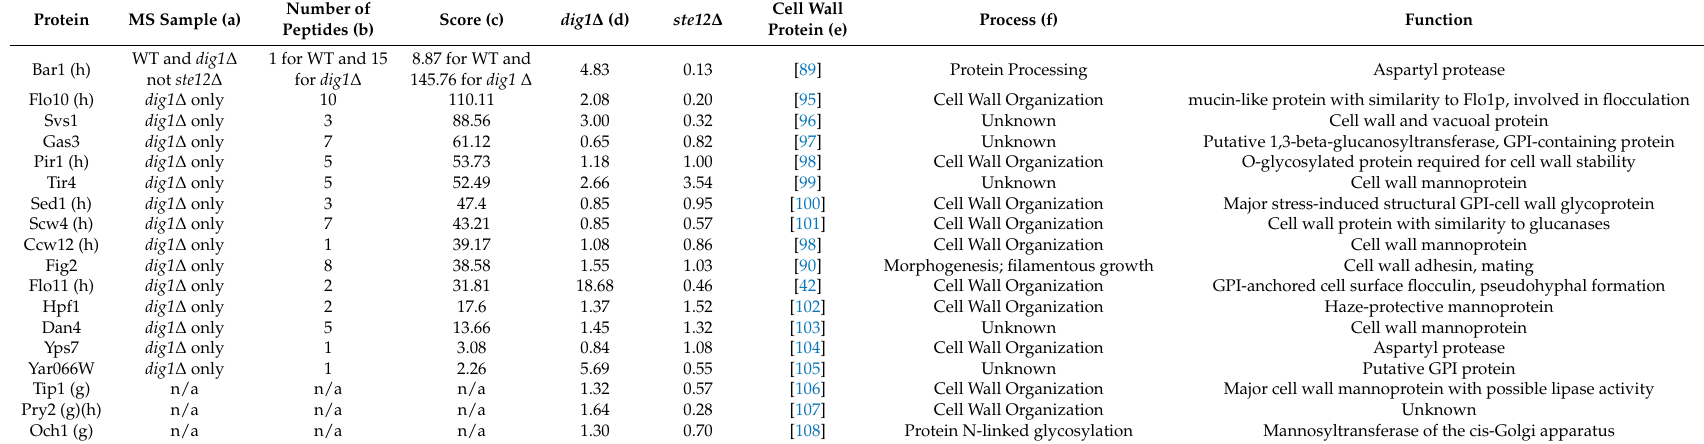
Table 3. Cell wall proteins that are candidate fMAPK pathway targets identified by MASS SPEC and/or comparative RNAseq analysis.